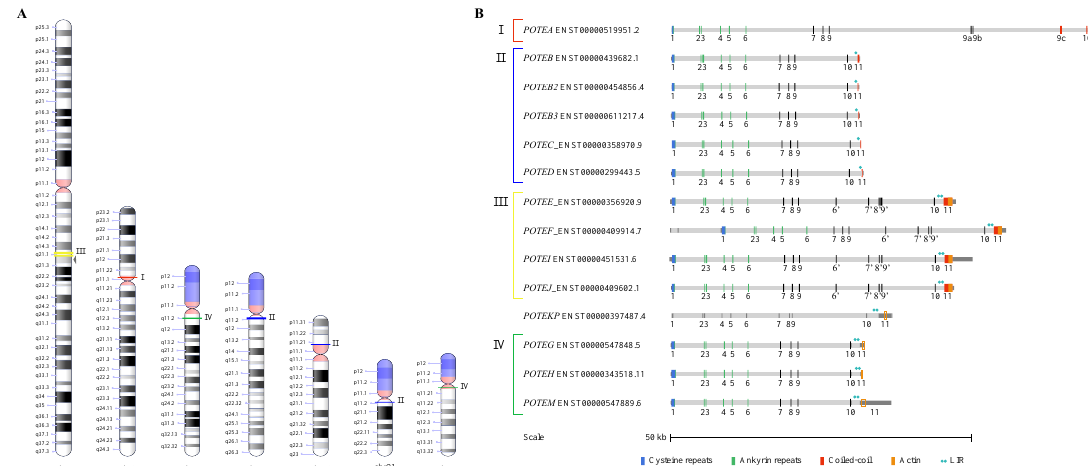
Figure 1. ( A ) Chromosome ideograms showing the localization of POTE (prostate, ovary, testis, and placenta expressed) genes in human. The colored bars indicate the four di ff erent POTE groups described later on in the results: red for group I, blue for group II, yellow for group III, and green for group IV. POTEKP mapping is indicated by the gray arrowhead. ( B ) Domain structure of the 14 canonical transcripts of human POTE genes. Coding (colored vertical bars) and noncoding (shorter and gray vertical bars) exons are shown and numbered on each transcript and are based on the Ensembl gene sequences. Half-sized LIR is indicated by a single light blue circle. Dark gray blocks flanking the transcripts indicate UTRs. Orange framed rectangles indicate actin-coding sequences outside of the